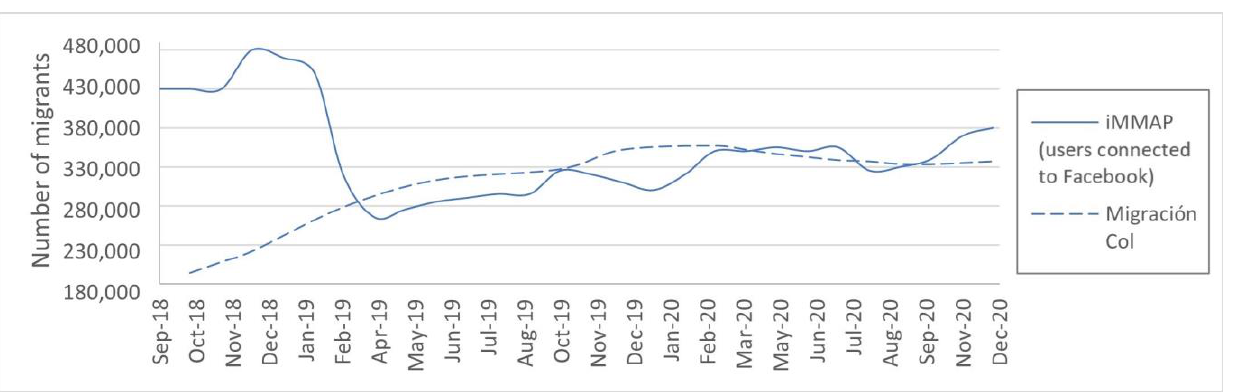
Figure 4. Comparison of Venezuelan migrants to Bogotá as reported by iMMAP vs. Migración Co- lombia.